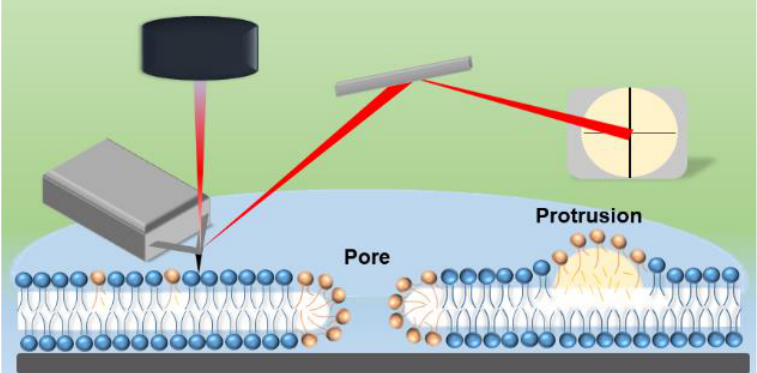
Figure 8. Schematic of the experimental AFM setup and supported PLPC bilayers after plasma treatment. Shown are both a pore and a protrusion. Brown color indicates fragmented or oxidized PLPC molecules, blue color the native state.